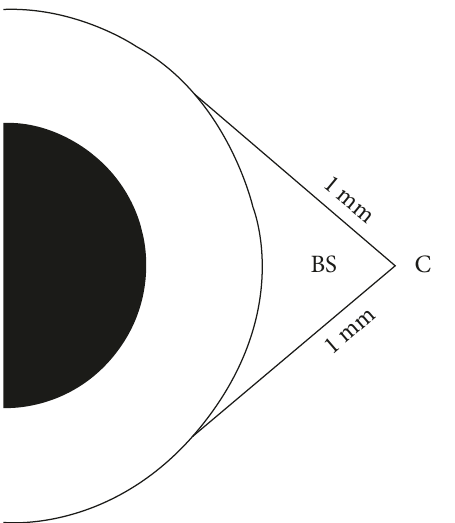
Figure 2: Schematic diagram showing the amount of bare sclera remaining after excision. BS =bare sclera; C